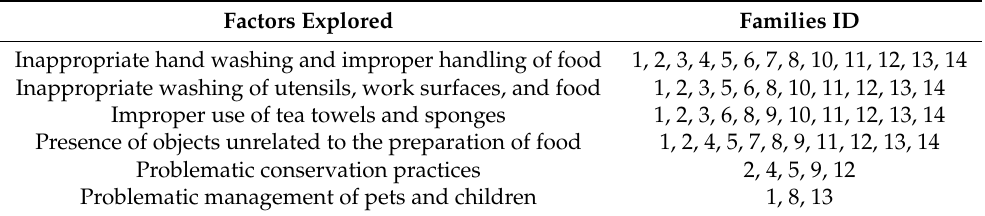
Table 3. Microbiological risk factors detected and families in which they were observed. Factors Explored Families